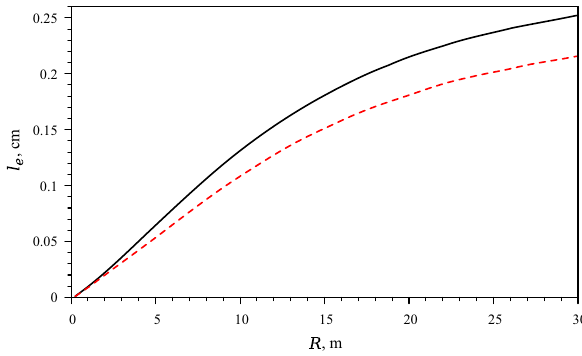
Fig. 2 Dependence of the relaxation length as a function of the radius of curvature for the crystal orientation along the (cid:2) 110 (cid:3) axis (black solid line) and along the (cid:2) 111 (cid:3) axis (red dashed line) with respect to the impinging